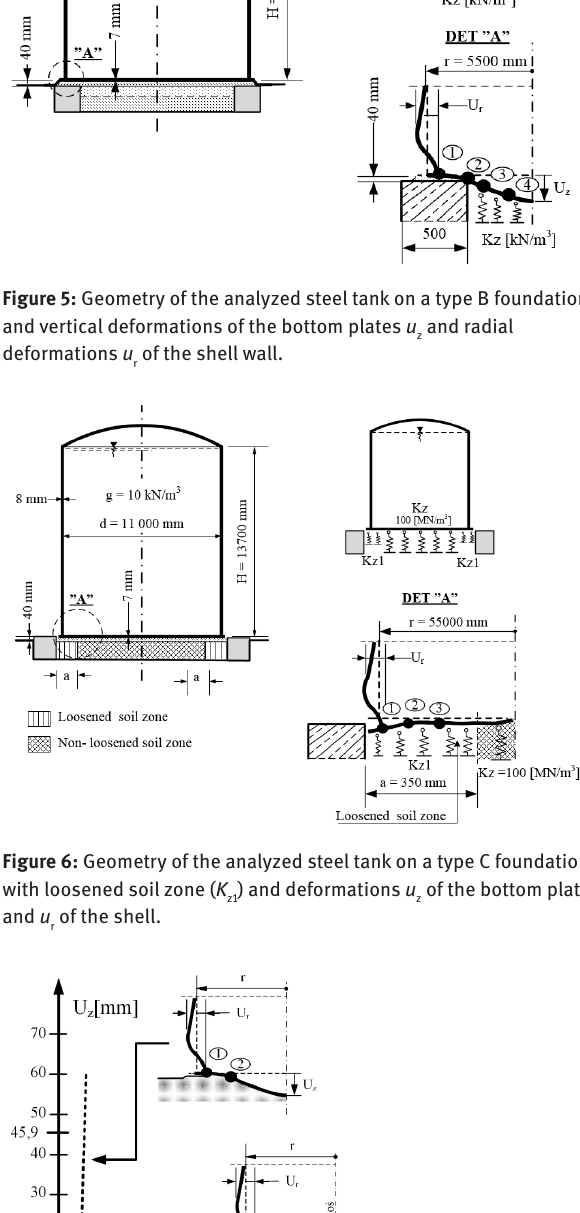
Figure 7: Comparison of vertical deformations u plates and radial deformations u type B foundations of uniform stiffness K